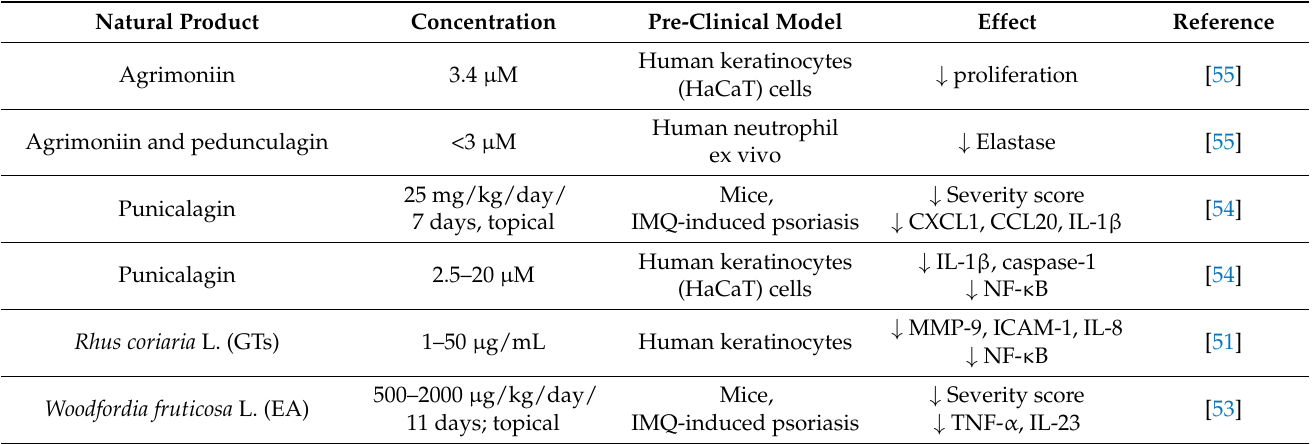
Table 2. Collection of recent articles concerning the biological activity of hydrolyzable tannins and their metabolites in psoriasis